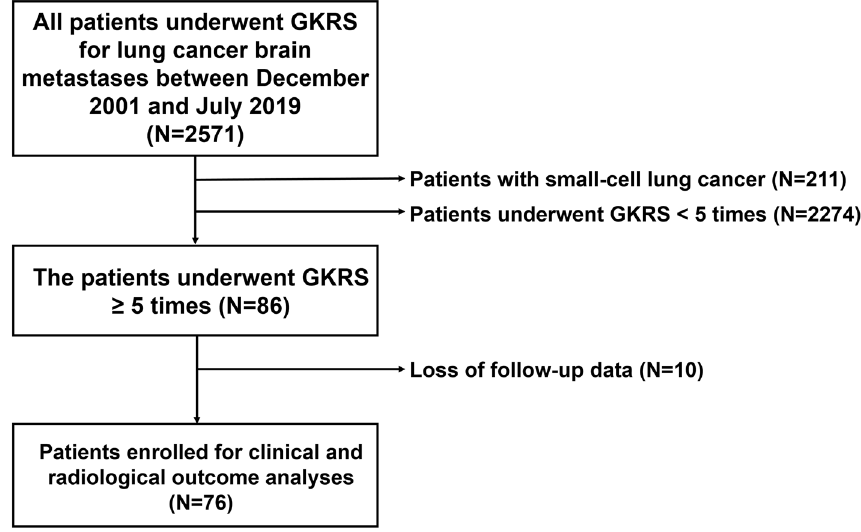
Figure 1. Flowchart showing the numbers of included and excluded